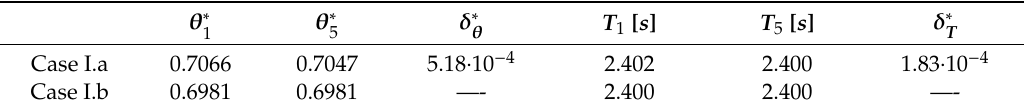
Table 7. Max amplitudes θ ∗ Cases II.a and